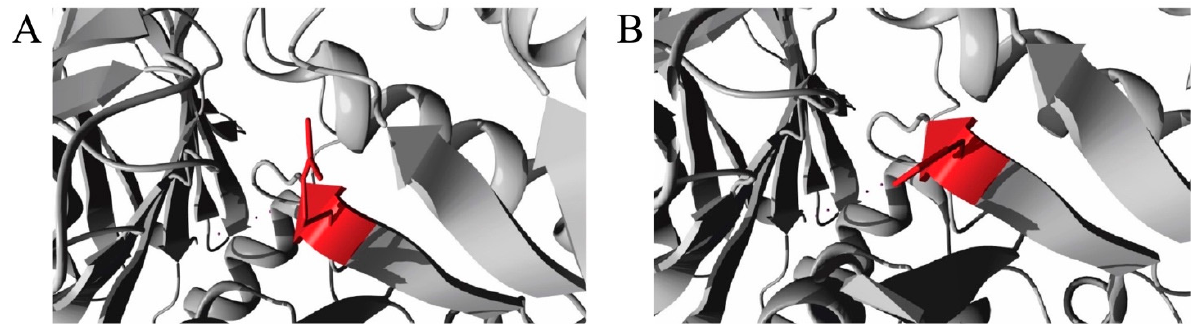
Figure 3. Molecular visualization of the wild-type ( A ) and the p.R600H mutant variant ( B ) of the amino acid in the feline GAA protein. The residues colored in red represent the wild-type (arginine) and variant residue (histidine) residues.